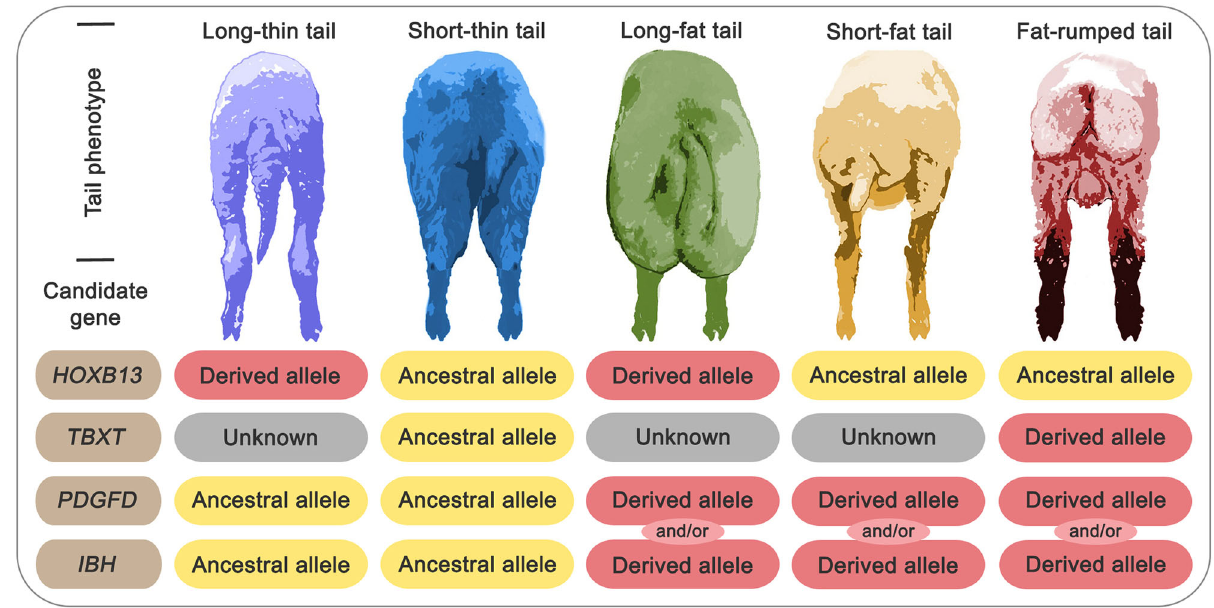
Fig. 1 A proposed hypothesis of the genetic structure of sheep tail patterning based on the currently known, signi fi cant four genomic signatures. The upper panel shows the main fi ve sheep tail phenotypic patterns, including the long-thin tail (e.g., Merino sheep), short-thin tail (e.g., Tibetan sheep), long- fat tail (e.g., Chinese Large-tailed Han sheep), short-fat tail (e.g., Chinese Hu sheep), and fat-rumped tail (e.g., Kazakh sheep). Note: Sheep tails characterized by intermediate tail length and level of fat deposition are shown in some breeds. This intermediate pattern of the fat tail can be categorized between the long-fat tail and the short-fat tail (shown in the third and fourth tail phenotypic patterns in the upper panel). The lower panel shows the main candidate genes/regions of the sheep tail phenotype (in brown boxes). These include two genes linked with the sheep tail length [ HOXB13 (refs. 21,23 ) and TBXT (refs. 16 – 18 )] and two genes/regions linked with the fat-tail phenotype [ PDGFD (refs. 1,11,12 ) and the intergenic region between BMP2 and HAO1 , referred to as the IBH region 13 – 15 ]. Yellow, red, and gray boxes indicate ancestral allele, derived allele, and currently unknown functional role, respectively. The icons of sheep tails used to construct this fi gure were adapted from Kalds et al. 3